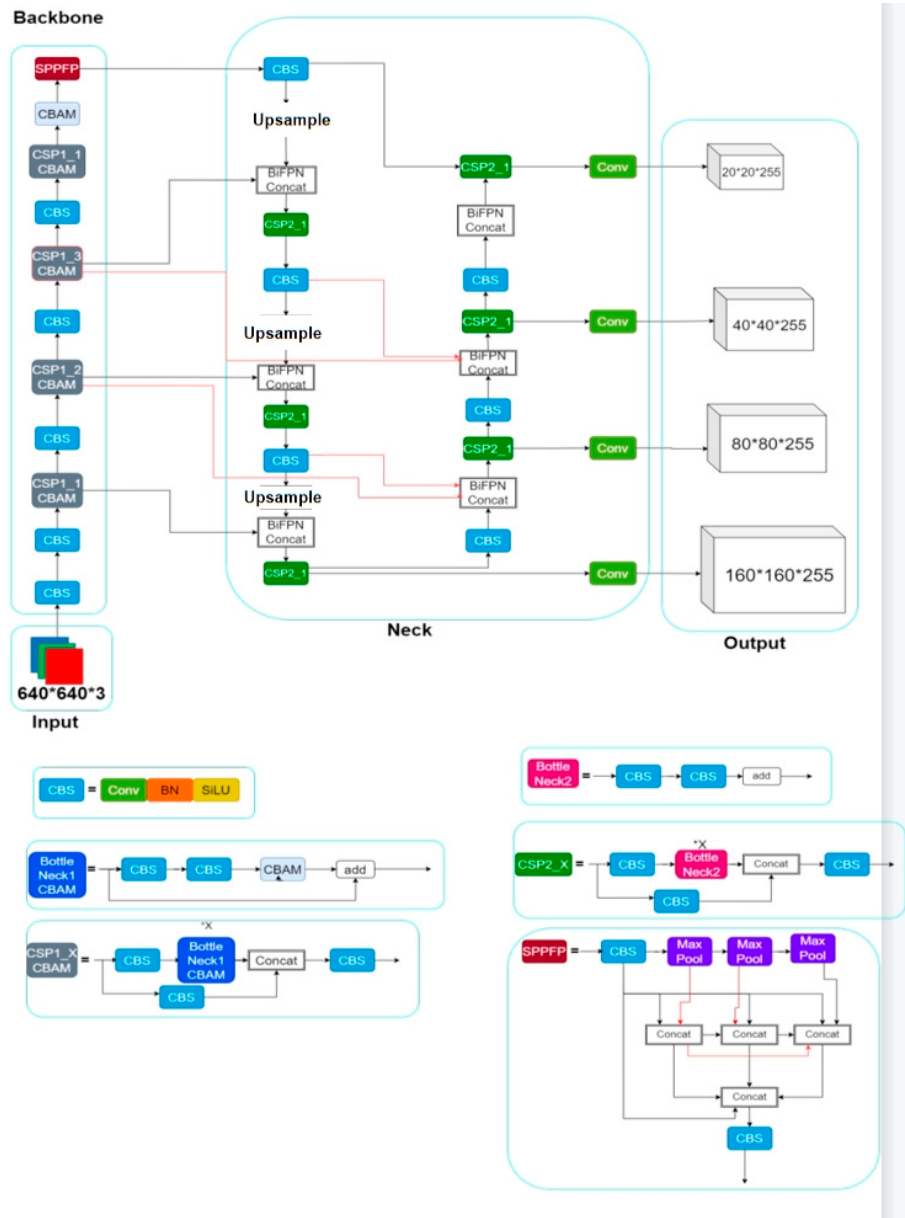
Figure 9. Improved version 6.1 of YOLOv5s.